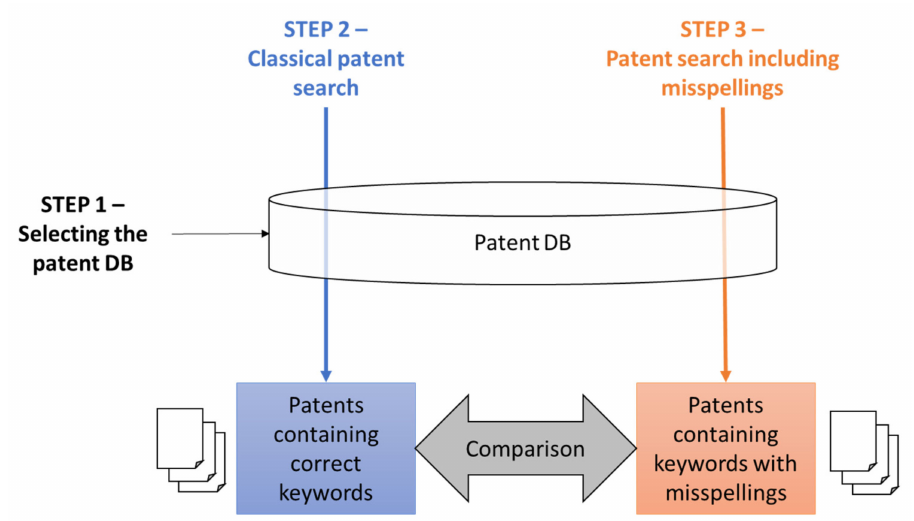
Figure 1. Graphical representation of the proposed algorithm to evaluate the impact of the mis- spellings in a patent